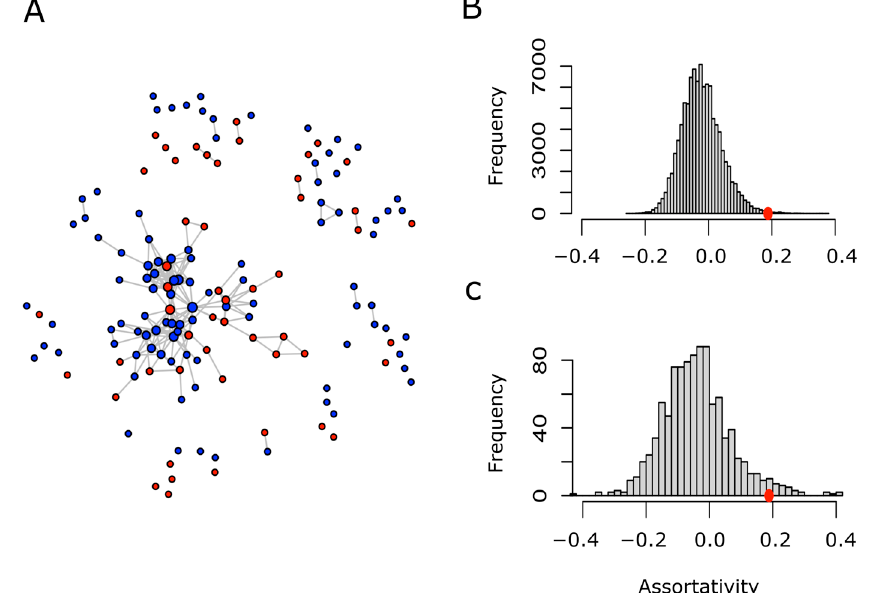
Figure 7. Network of human PrLD proteins and assortativity analysis. Two given proteins (nodes) are connected (linked by an edge) if they share at least 25% of their GO terms. Proteins belonging to the MR-PrLD set are shown in red, while those from the Non-Met-PrLD set are shown in blue ( A ). Retaining the network topology and the proportion of red and blue nodes, each node was randomly relabeled as red or blue, then the assortativity coefficient of the relabeled network was computed. This process was repeated 105 times, and the assortativity distribution was plotted ( B ). On the other hand, the human proteome was randomly sampled to obtain as many proteins as nodes present in A. Using the same binary relationship (two proteins are connected if they share at least 25% of their GO terms), a network was built. Afterwards, each node was randomly labeled as red or blue, keeping the proportion shown in A. This process was repeated 1000 times and, in each case, the assortativity coefficient was computed. The distribution of the assortativity coefficient computed in this way was plotted ( C ). The red circles in B and C point to the assortativity coefficient value (0.188) computed for the actual network shown in